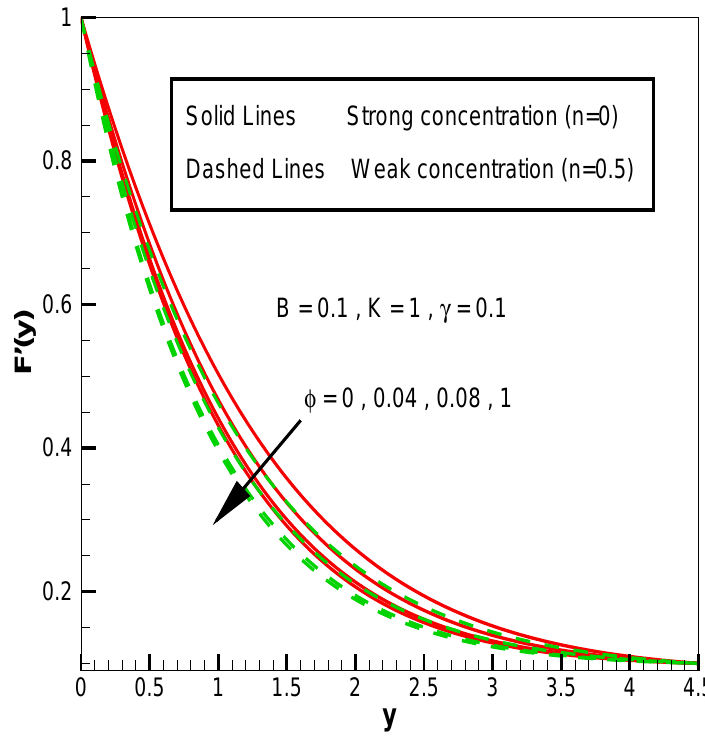
Figure 2. 𝐅 (cid:4593) (𝐲) for material parameter 𝐊 .